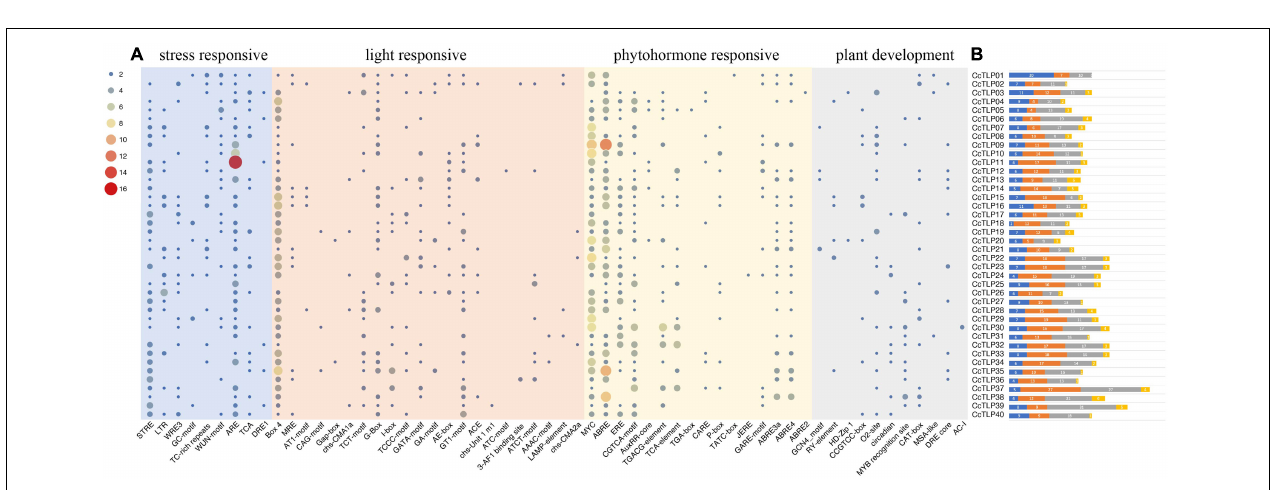
FIGURE 3 | Rectangular phylogenetic tree, gene structure, and motif distribution of CcTLP genes. (A) The phylogenetic tree was inferred based on 40 hickory TLP peptides sequences. (B) Gene structure of Cc TLP genes including 5 (cid:48) and 3 (cid:48) -UTR (yellow bar), exon (green bar), and intron (black line). (C) Motif patterns in 40 CcTLP genes.